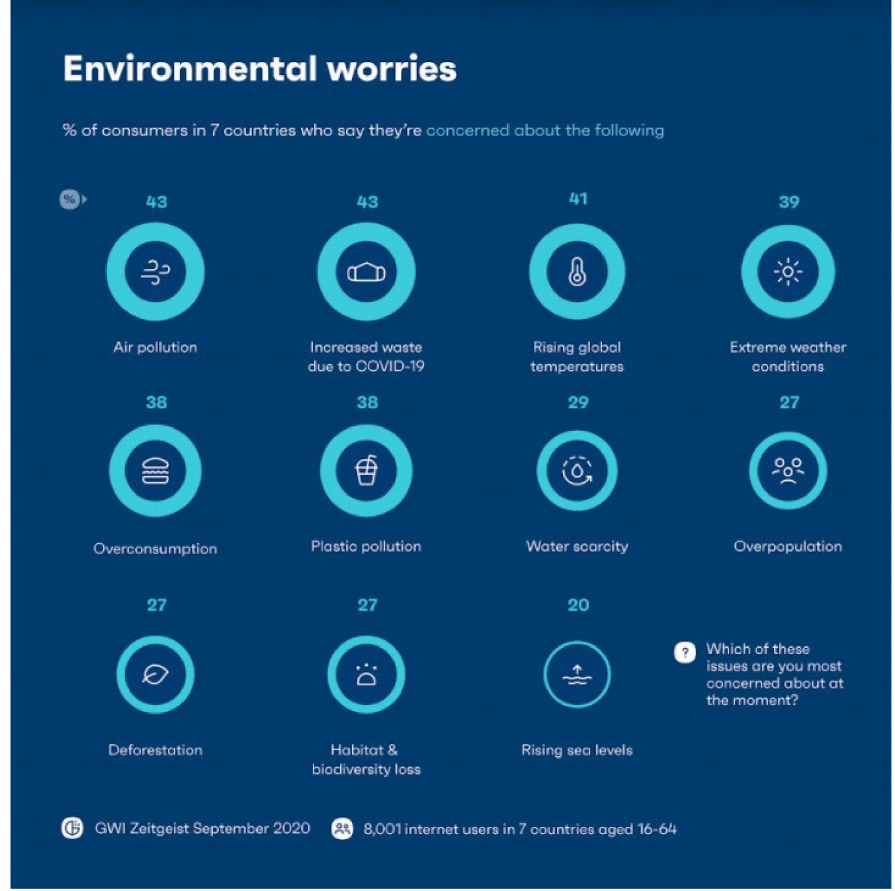
Figure 12. Consumer environmental worries (by courtesy of GWI [61]). Consequently, this pandemic crisis has accelerated the focus on sustainability and planetary changing, increasing the people’s concern for their own and planet health. Thus, consumers have a major interest in cosmetic ingredients’ quality and provenience, the content of the final product and its overall environmental impact from the production to its consumption [64]. Consequently, the demand for products made from natural ingredients and attractive for their biodegradable packaging boost the global cosmetic market, generating an estimated USD 380.2 billion in 2019 and projected to reach USD 463.5 billion by 2027 with an estimated Compound Annual Growth Rate (CAGR) from 5.3% to 7% from 2021 to 2027, with a high increase of natural products (Figure 13) [64]. Regarding the regions, Asia–Pacific accounted for the highest share, contributing in 2019 more than one-third of the market. Moreover, according to the Cosmetic Europe data [65] in the global market with a value of USD 286.7 billion. Europe remains the largest market in the world with a value at retail price of USD 79.8 billion and in 2019 with over 2 million jobs (Figure 14), in comparison with USD 73.7 billion in USA, 54.9 in China, 32.6 in Japan, 23.4 in Brazil, 12.0 in India and 10.3 in South Korea, respectively (Figure 15)